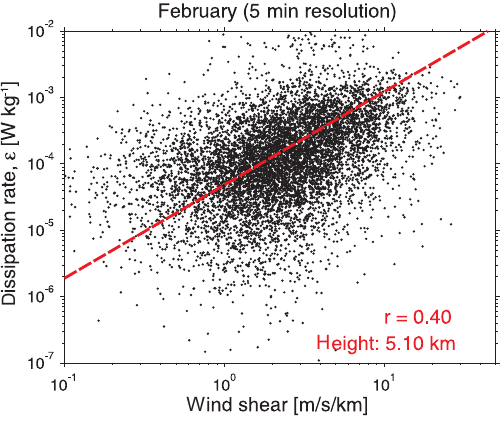
Figure 16. Same as Fig. 15, but for the results derived based on all the data with 1h resolution in February in the years 2010–2013 at altitudes of 5.1–9.0km. The corresponding correlation coefficient r is indicated in the lower right corner, which is highly significant, i.e. well above the 99.9% level.